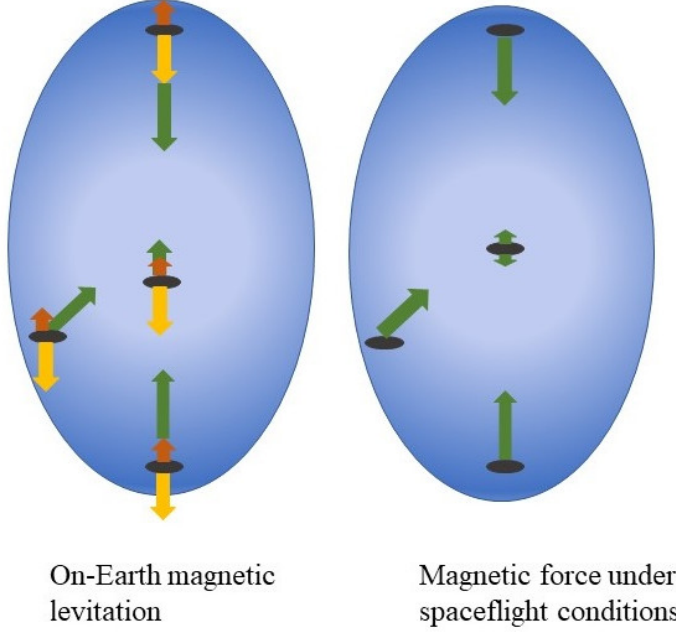
Figure 1. Forces that affect the bacterium in suspension within the non-homogenous magnetic field on Earth and under microgravity (spaceflight) conditions. On Earth, the bacterium experiences three forces, which are gravitational, Archimedes, and magnetic. Magnetic levitation is achieved at the point where the vector sum of the magnetic and Archimedes forces counterbalances gravity. Under spaceflight conditions, the magnetic force is the only force, it pushes the bacterium to the area of the lowest magnetic field. Green arrows—the magnetic force; yellow arrows—gravity; brown arrow—the Archimedes force. The gradient of the blue represents the magnetic field gradient: the magnetic flux density decreases as the distance from magnets increases and is the lowest in the center. (The figure modified [19]).